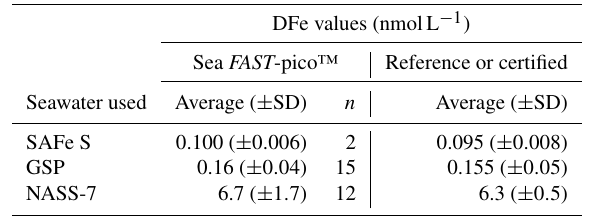
Table 2. SAFe S, GSP, and NASS-7 dissolved iron concentrations (DFe, nmolL-1) determined by the sea FAST -pico™ instruments and their consensus (SAFe S, GSP; https://websites.pmc.ucsc.edu/ ~kbruland/GeotracesSaFe/kwbGeotracesSaFe.html, last access: 30 January 2020) and certified (NASS-7; https://www.nrc-cnrc.gc. ca/eng/solutions/advisory/crm/certificates/nass_7.html, last access: 30 January 2020) DFe concentrations. Note that no consensual value is reported for the GSP